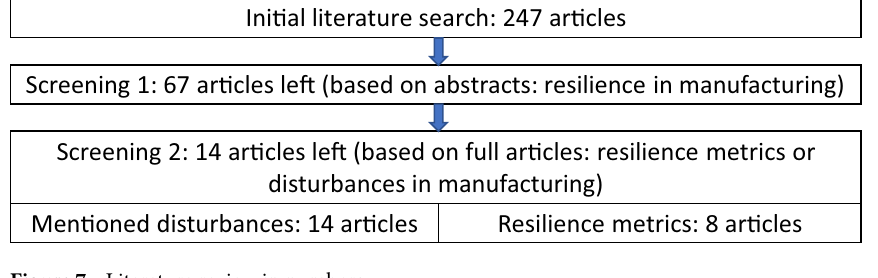
Figure 7. Literature review in